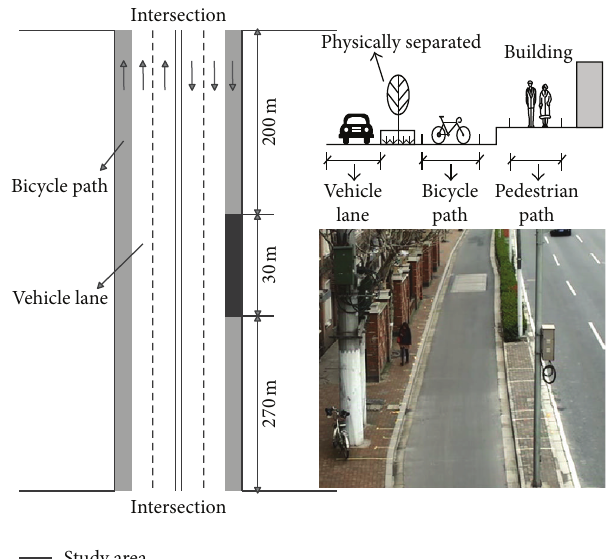
Figure 1: Layout of the data investigation